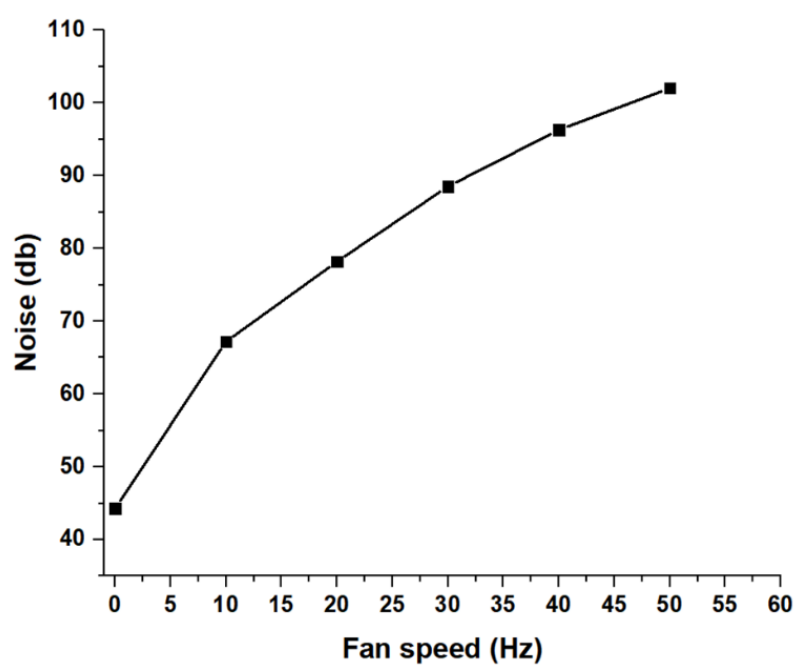
Figure 17. The relationship between the wind tunnel fan frequency and the corresponding measured noise.